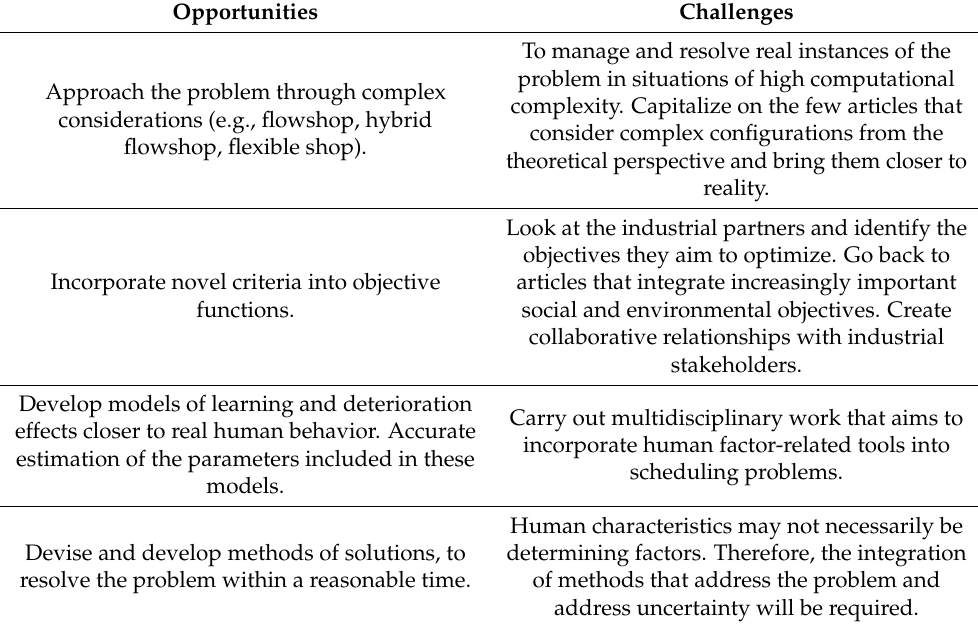
Table 2. Opportunities and challenges for the scheduling problem with learning and deterioration